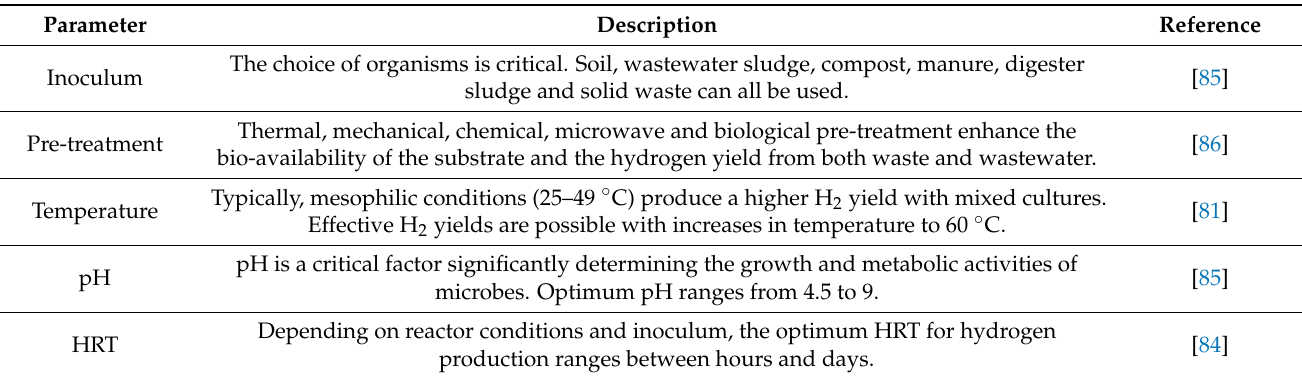
Table 9. Key parameters influencing dark fermentative H 2